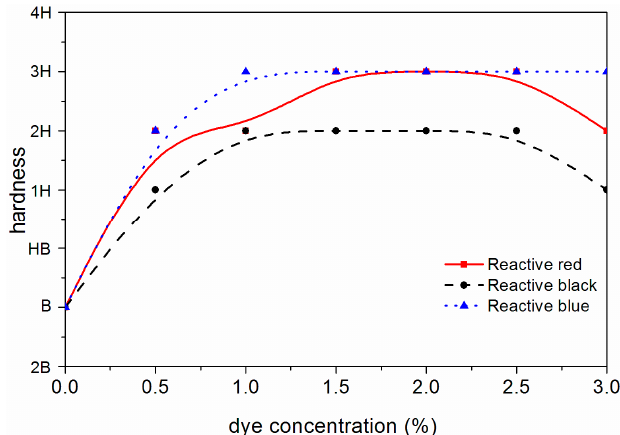
Figure 8. Variation trend of waterborne coating hardness on the F. mandshurica veneer after dyeing.